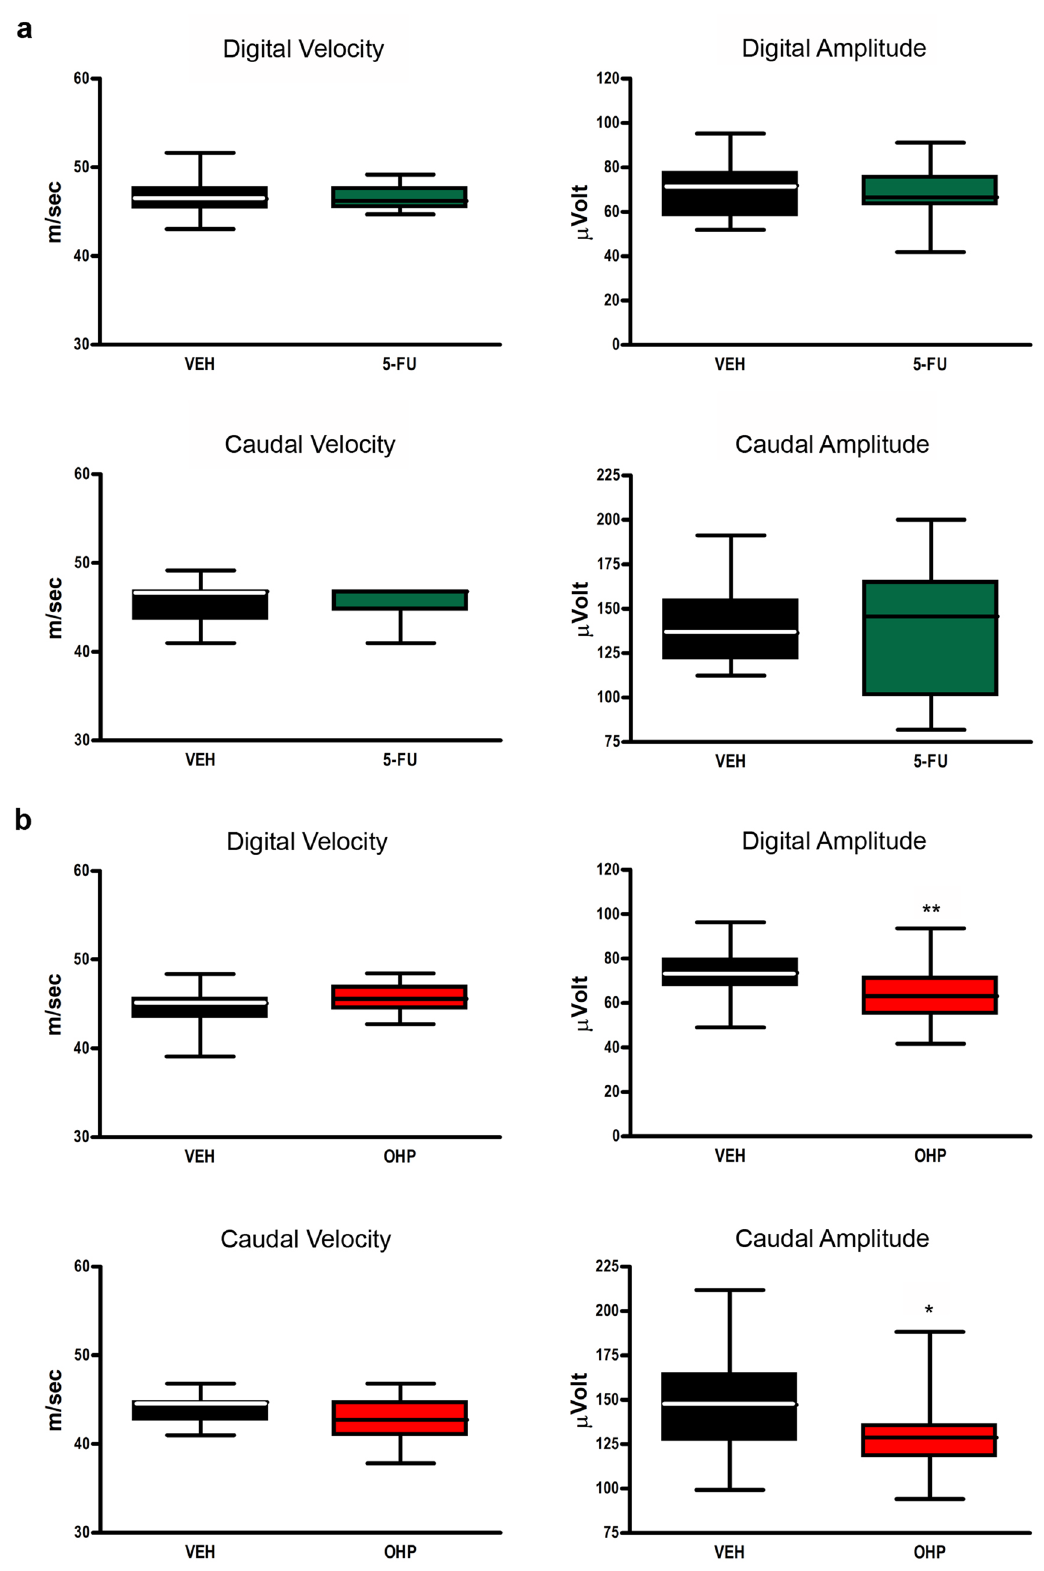
Figure 5. Nerve conduction studies at the end of the treatment. ( a ) neurophysiological parameters of both caudal and digital nerves in the 5-FU experiment: no statistical significance was demonstrated for any tested parameter. ( b ) neurophysiological parameters for OHP experiment; statistical significance for Mann–Whitney U test is shown (*p < 0.05; **p <